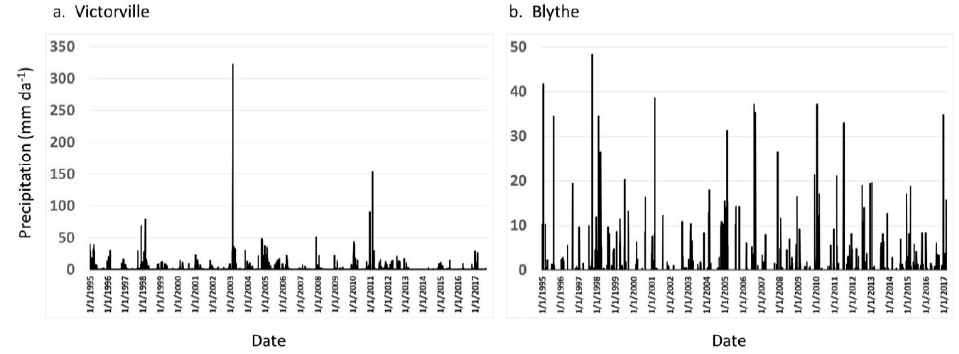
Figure 10. Daily precipitation records for two weather station locations within the study area. Note that the vertical axes have different ranges of precipitation values.